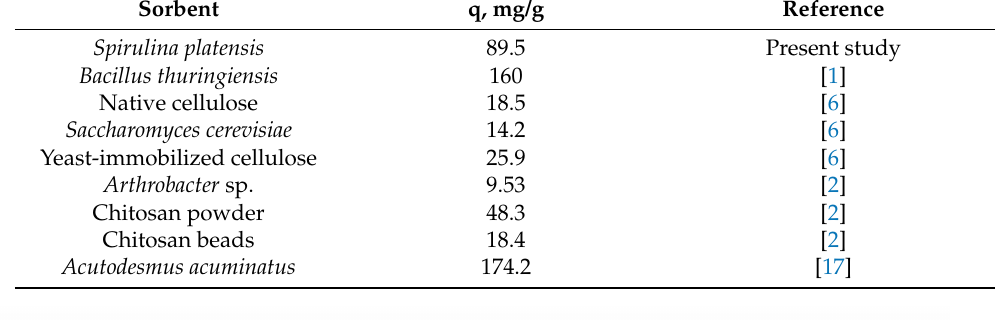
Table 2. Comparison of A. platensis sorption capacity with the literature data.